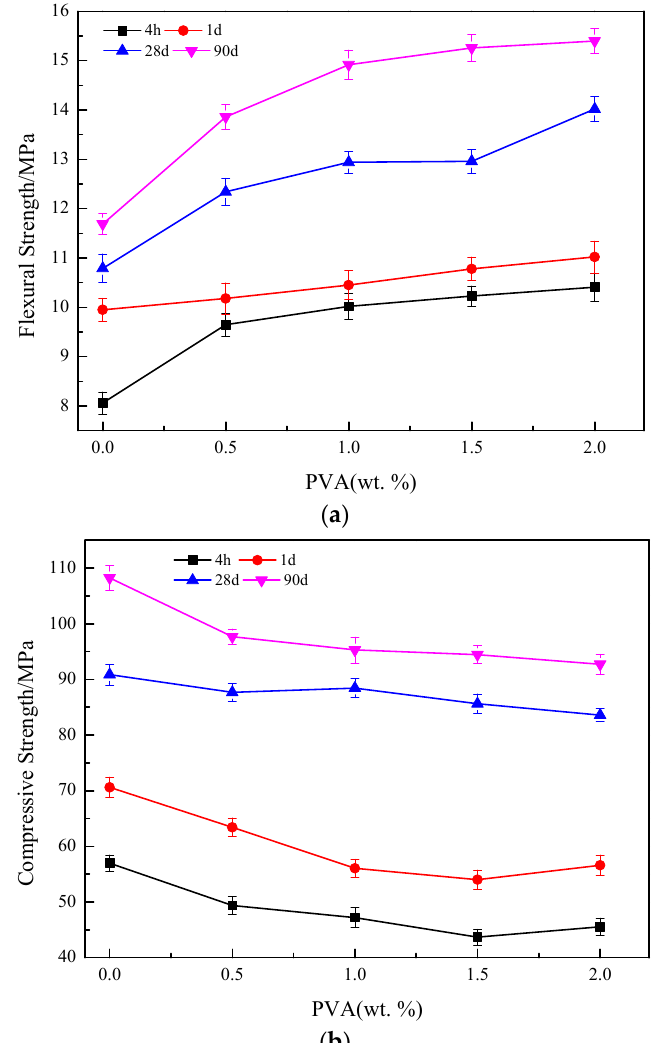
Figure 2. Mechanical properties of mortar. ( a ) The flexural strength of mortar; ( b ) the compressive strength of mortar.